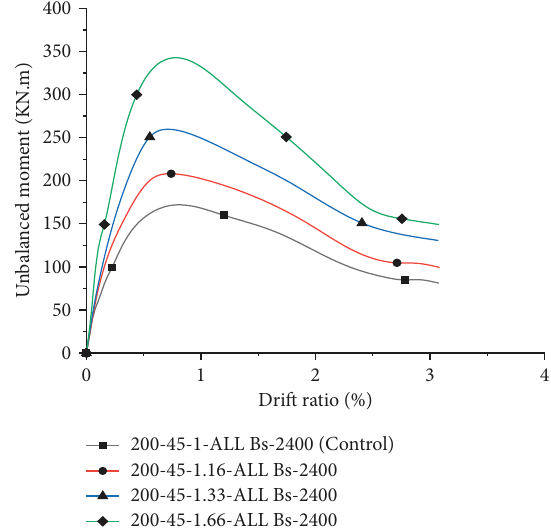
Figure 42: Efect of column aspect ratio on unbalanced moment drift